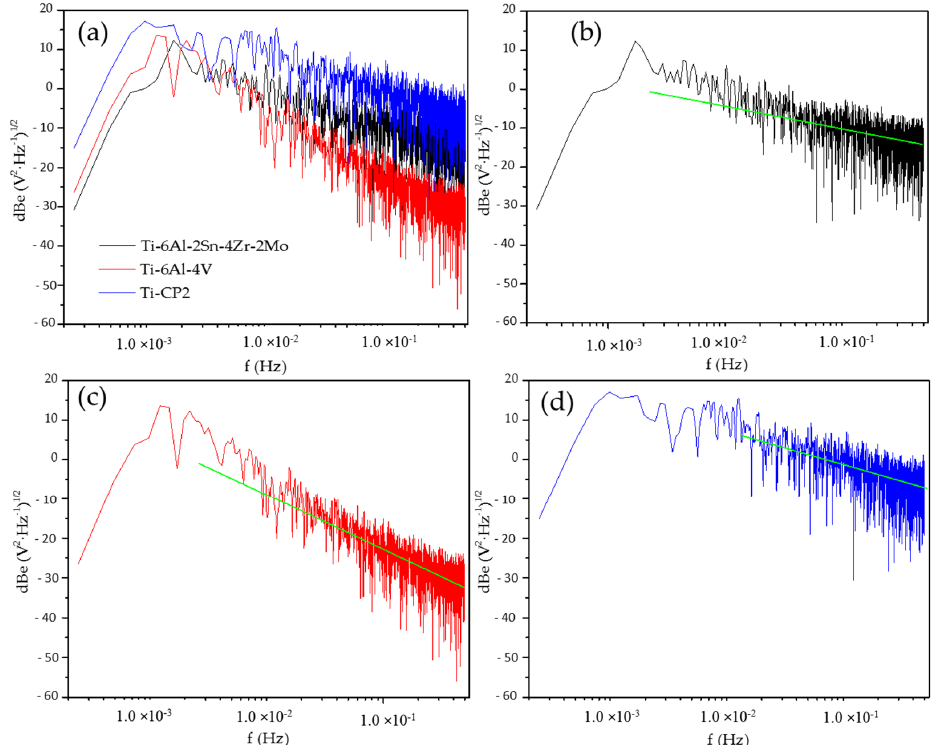
Figure 5. PSD voltage in NaCl ( a ) all samples, ( b ) Ti-6Al-2Sn-4Zr-2Mo, ( c ) Ti-6Al-4V, and ( d ) Ti CP2.